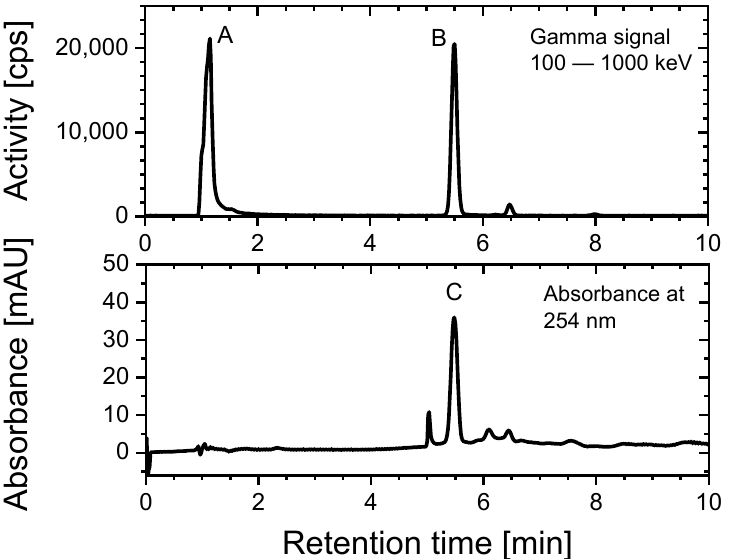
Figure 8. HPLC chromatogram of the labelling reaction of [Al(OH)(NODA*)] with [ 18